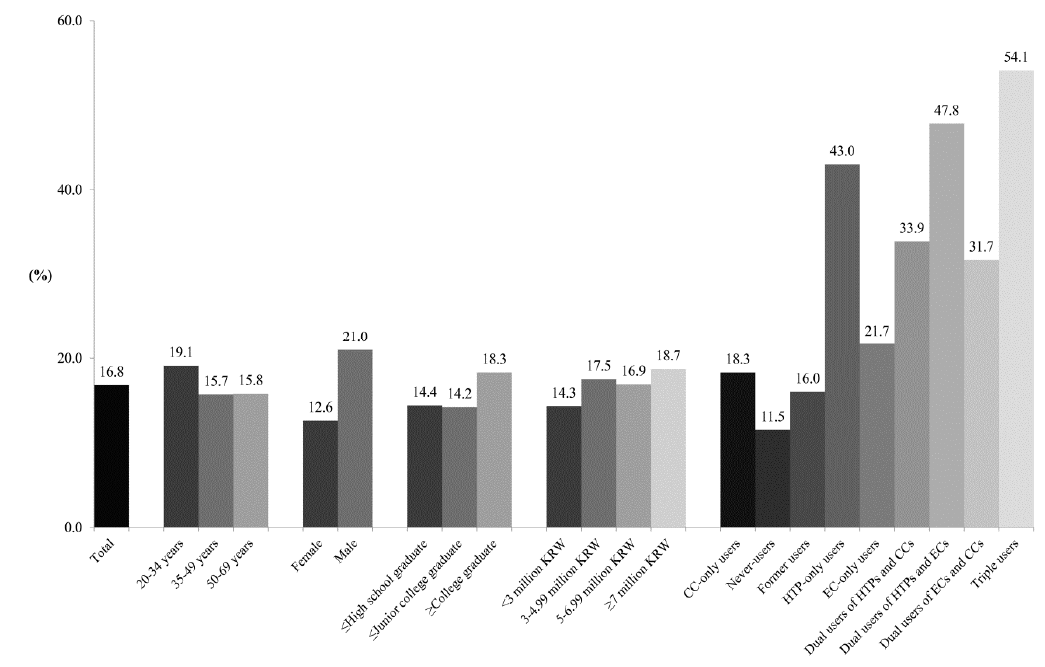
Figure 1. Frequency of the belief that HTPs are less harmful than CCs. Abbreviations: CCs = combustible cigarettes; HTPs = heated tobacco products; ECs = electronic cigarettes; KRW = Korean Republic Won (KRW 1000 = US Dollar 1). Values are presented as weighted percentages (the weighted % of women was 50). Table 2. Comparison of beliefs about the harmfulness of HTPs compared with CCs, and the